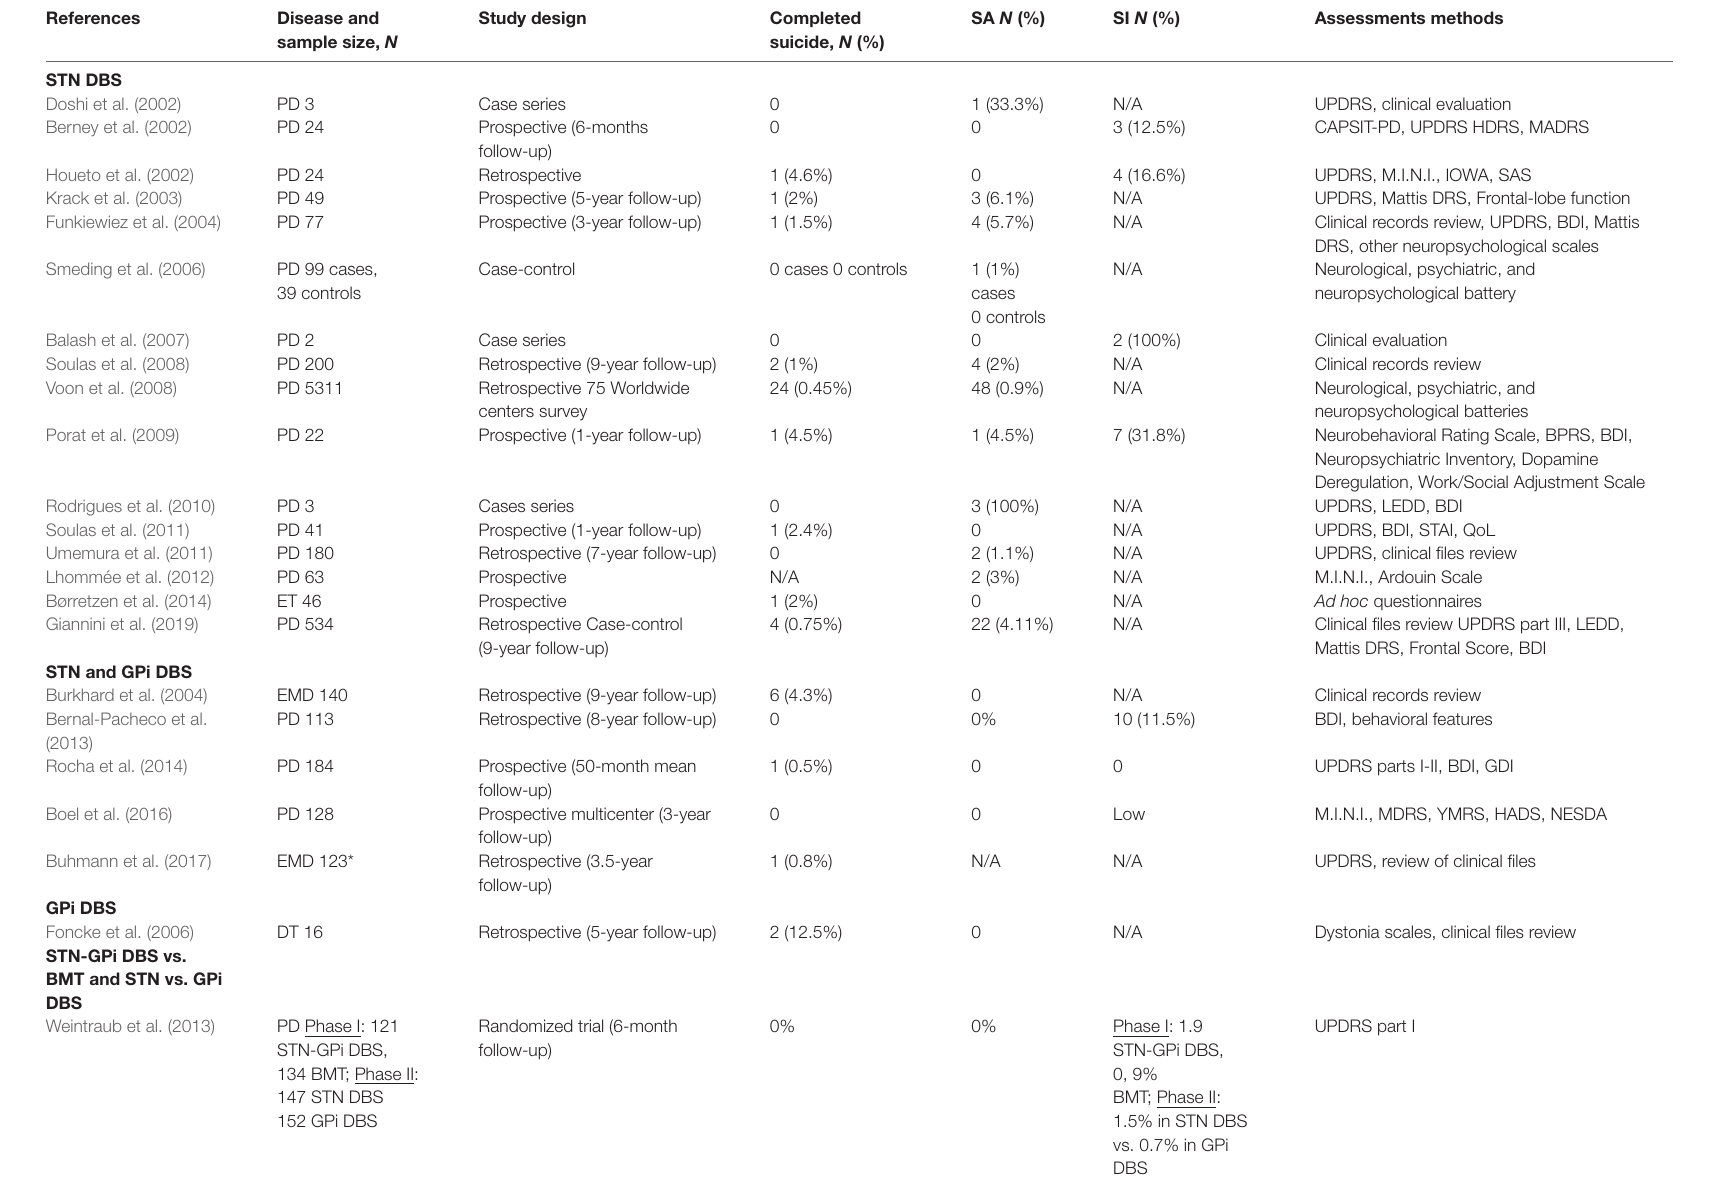
TABLE 1 | Original studies on suicidality in patients who underwent deep brain stimulation